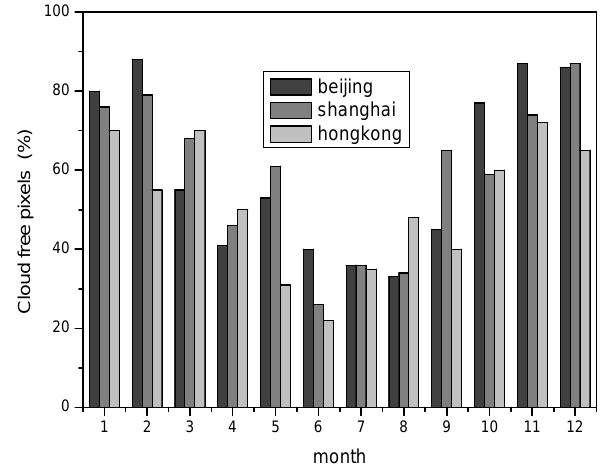
Figure 6. Percentage of cloud free and ozone quality flagged IASI pixels per month for the 3 regions for the year 2008.